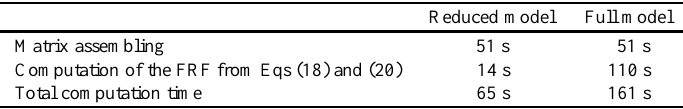
Time to compute the FRF’s for the reduced and complete plate models